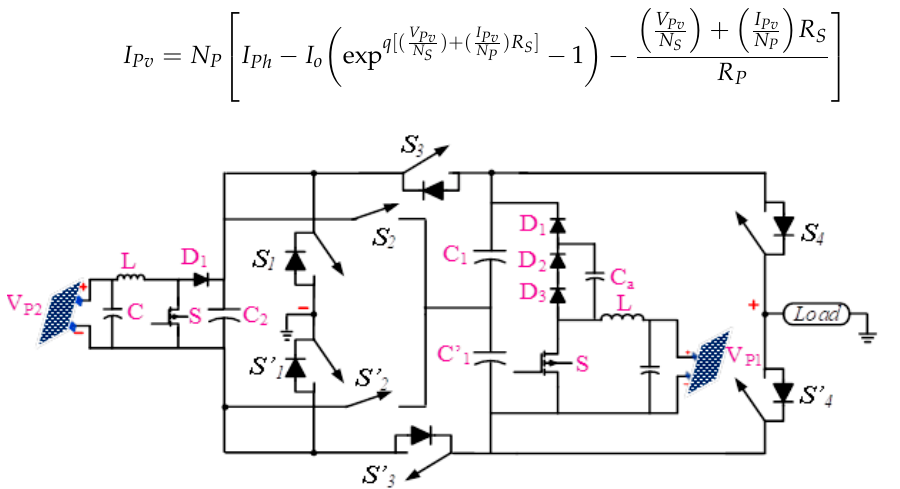
Figure 5. Schematic arrangement of PV sourced proposed module.